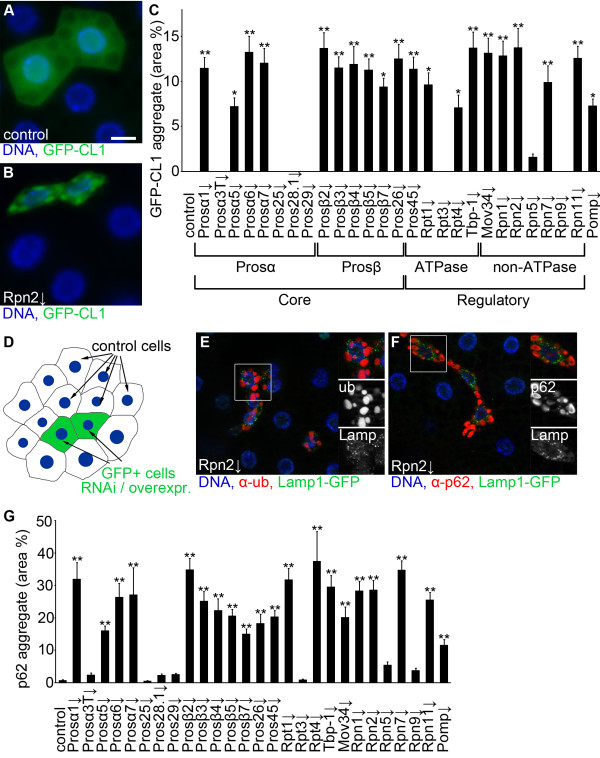
Depletion of genes encoding various proteasome subunits decreases proteasomal activity in vivo. A) Control cells expressing the proteasome degradation reporter GFP-CL1 are similarly sized as neighboring non-GFP control fat body cells and show diffuse fluorescence. Cell nuclei are labeled with DAPI (blue). B)Rpn2 RNAi cells are smaller than control cells and accumulate large aggregates of GFP-CL1. C) Proteasome RNAi leads to accumulation of GFP-CL1 aggregates relative to control cells shown in panel A. Statistically significant differences are marked by asterisks (Kruskal-Wallis test, n = 5-6 per genotype, ** P < 0.01, * P < 0.05), and error bars denote standard error. The different types of subunits are indicated as 20S core subunits (α and β), and 19S regulatory particle subunits (ATPase and non-ATPase). Pomp is required for assembly of the 20S core. D) Schematic of the clonal expression system. GFP-positive cells of interest are surrounded by wild-type cells in the same tissue of mosaic animals, serving as an internal control in various staining experiments. E) Depletion of Rpn2 leads to accumulation of ubiquitinated protein aggregates in Lamp1-GFP marked fat body cell clones. Note that the numerous small Lamp1-GFP dots representing lysosomes are not ubiquitin-positive. F) Similarly, silencing of Rpn2 leads to cell-autonomous accumulation of p62 aggregates in Lamp1-GFP marked fat body cell clones. Note that Lamp1-GFP dots are not p62-positive either. G) Proteasome RNAi leads to accumulation of endogenous p62 aggregates relative to control cells. n = 5-6 per genotype. Statistically significant differences are marked by asterisks (Kruskal-Wallis test, n = 5-6 per genotype, ** P < 0.01, * P < 0.05), and error bars denote standard error. Boxed areas in E and F are shown enlarged. Scale bar in A equals 20 μm for A, B, E, F.